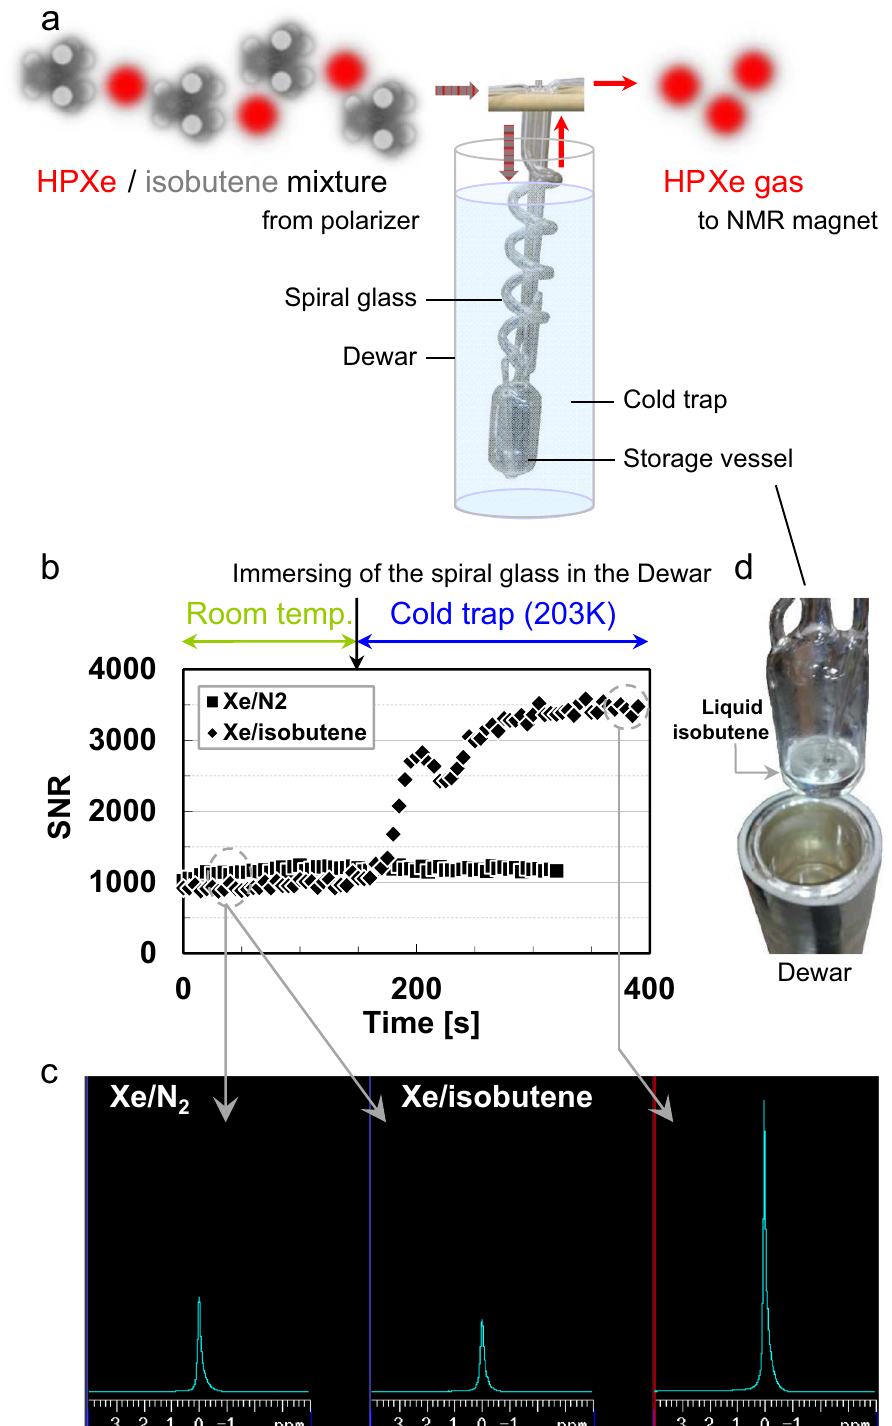
Figure 1. Dynamics of 129 Xe NMR signal enhancement by removing isobutene. ( a ) Diagram of the glassware for condensing and storing isobutene using a cold trap and schematic diagram of the production of concentrated HP 129 Xe gas from the Xe/isobutene gas mixture. ( b ) Time course of SNR of 129 Xe spectrum using gas mixtures with Xe/isobutene (diamonds) and Xe/N 2 (rectangles). Spiral glass piping was immersed in a Dewar at the time point indicated by the black allow to trap isobutene at 203 K. The Xe fraction in both mixtures was f Xe,SEOP = 0.20. Gas flow rates of Xe, isobutene, and N 2 were F Xe = 17, F ib = 69 and F ( c ) HP 129 Xe NMR spectrum acquired from a Xe/N 2 gas mixture (left) and a Xe/isobutene gas mixture recorded before (center) and after separation of isobutene using the cold trap (right). ( d ) Photograph of the liquid isobutene separated from Xe gas and stored in the storage